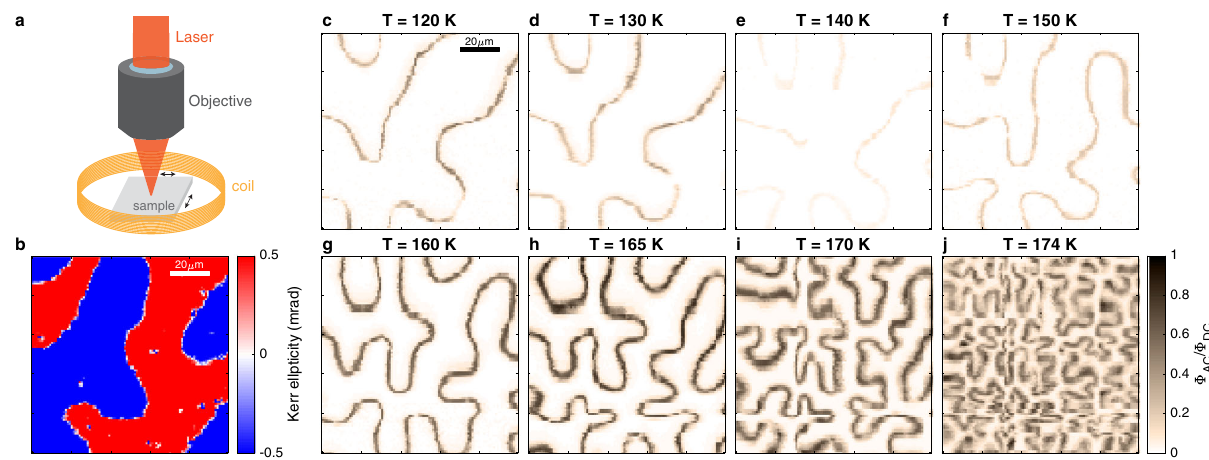
Fig. 1 Scanning Kerr microscopy. a Overview of ac MOKE microscopy setup. The sample is surrounded by a coil that generates an out-of-plane ac magnetic fi eld. b Unmodulated Kerr ellipticity map taken at T = 120 K reveals stripe-like magnetic domains. c – j ac MOKE maps measured at temperatures ranging from 120 to 174 K. A 28 Oe ac magnetic fi eld was applied at a frequency of 1 kHz. The normalized ac Kerr ellipticity amplitude Φ AC = Φ DC is signi fi cantly reduced at 140